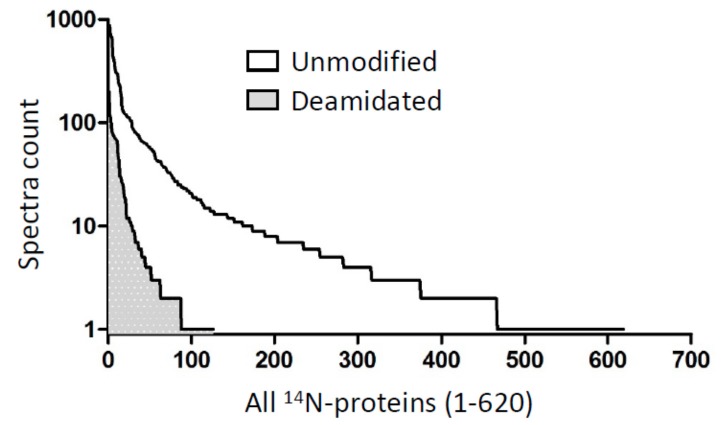
Among all ~600 lens 14N-proteins (x-axis), when calculated on the basis of peptide spectra (y-axis), about 10.2% peptides were deamidated (1560 vs. 13703 for deamidated and unmodified peptides).